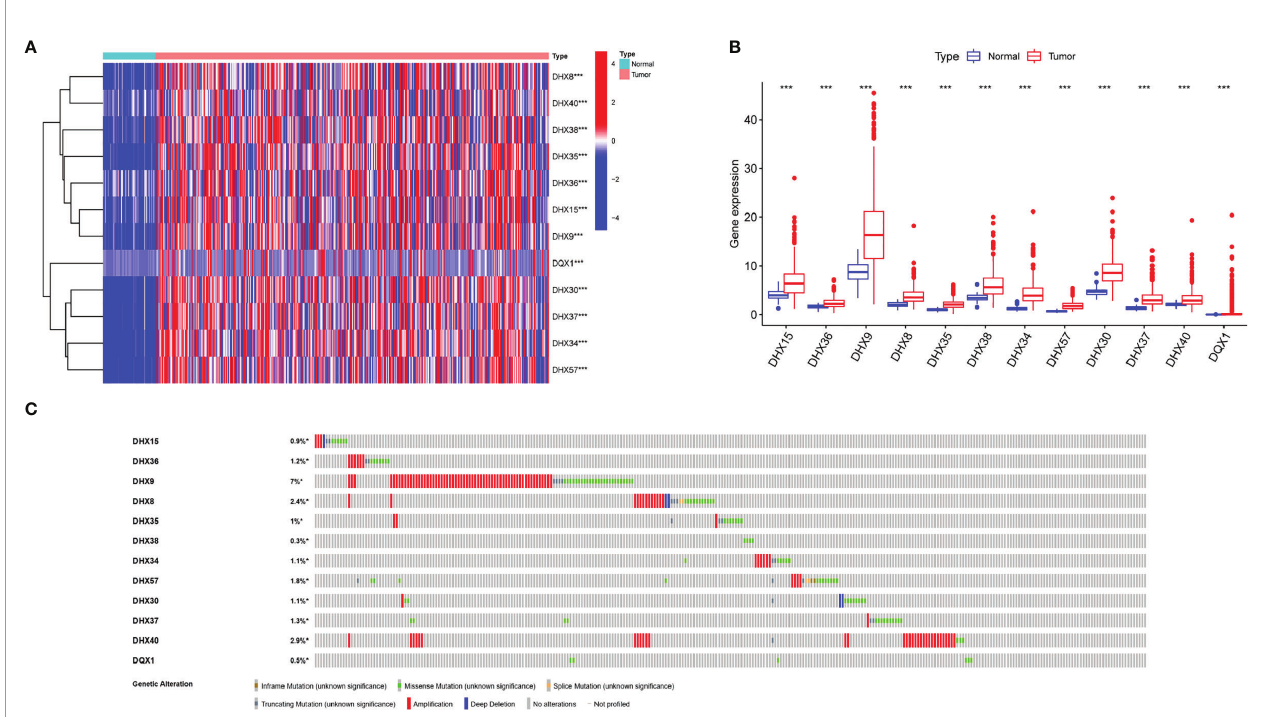
FIGURE 1 | Transcriptional levels and genetic alterations of prognostic DEAH-box RNA helicases in liver hepatocellular carcinoma (LIHC). (A) Differential expression heatmap and (B) boxplot of prognostic genes in LIHC and normal tissues based on TCGA. (C) Gene alteration of prognosis-related helicases in LIHC based on cBioPortal data. *** p <